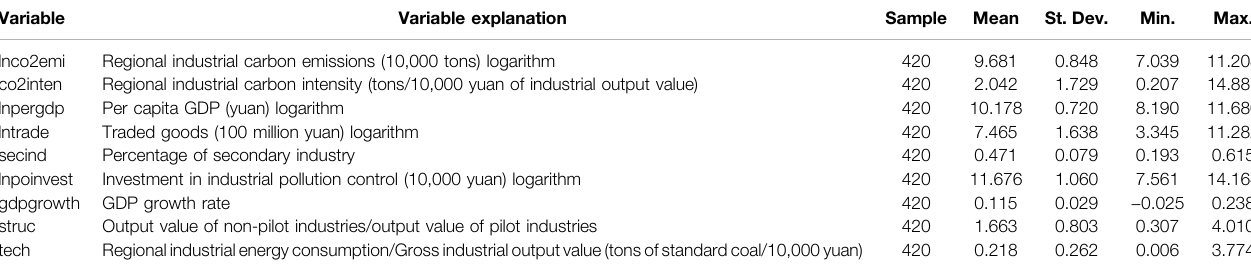
TABLE 1 | Variable explanations and descriptive statistics. Variable Variable explanation